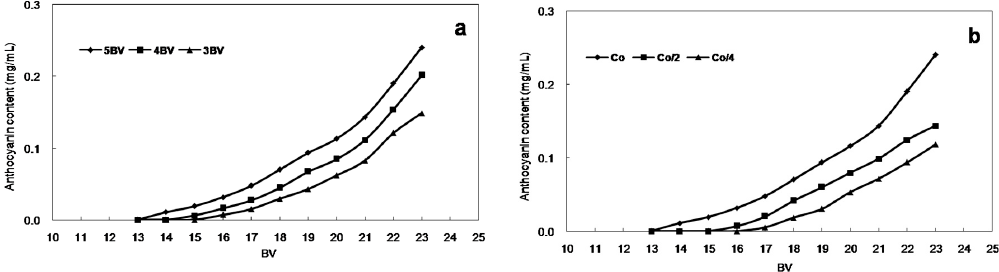
Figure 4. Leakage curves with ( a ) different current velocity and ( b ) different sample concentrations.